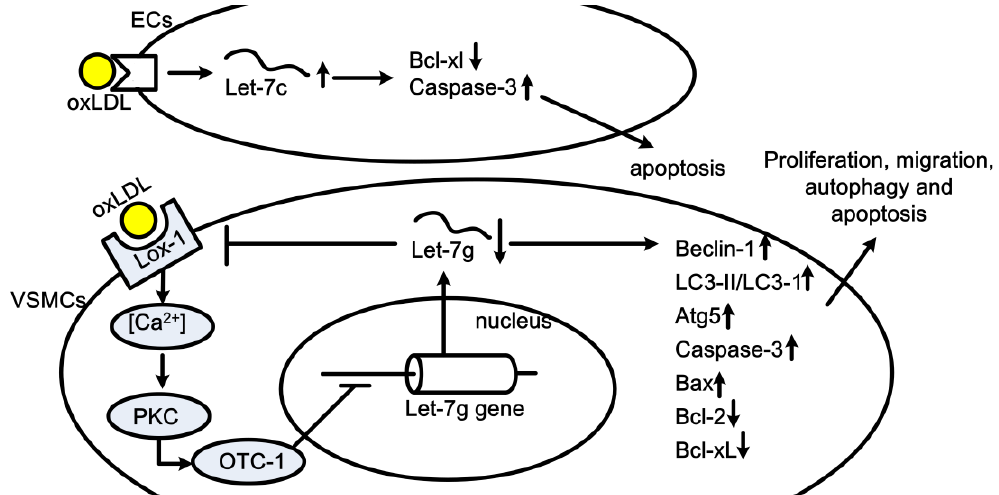
Figure 4. Roles of let-7 in oxLDL induced VSMCs and ECs apoptosis, proliferation, migration and autophagy. OxLDL induces EC apoptosis via let-7c and subsequent Bcl-xl and Caspase-3. In oxLDL treated VSMCs, oxLDL suppresses let-7g expression via LOX-1/Ca 2+ /PKC/OTC-1 signaling pathway, the let-7g then targets on Beclin-1, LC3-II (LC3-I), Atg5, Caspase-3, Bax, Bcl-2, and Bcl-xl, and regulates the proliferation, migration, autophagy and apoptosis of